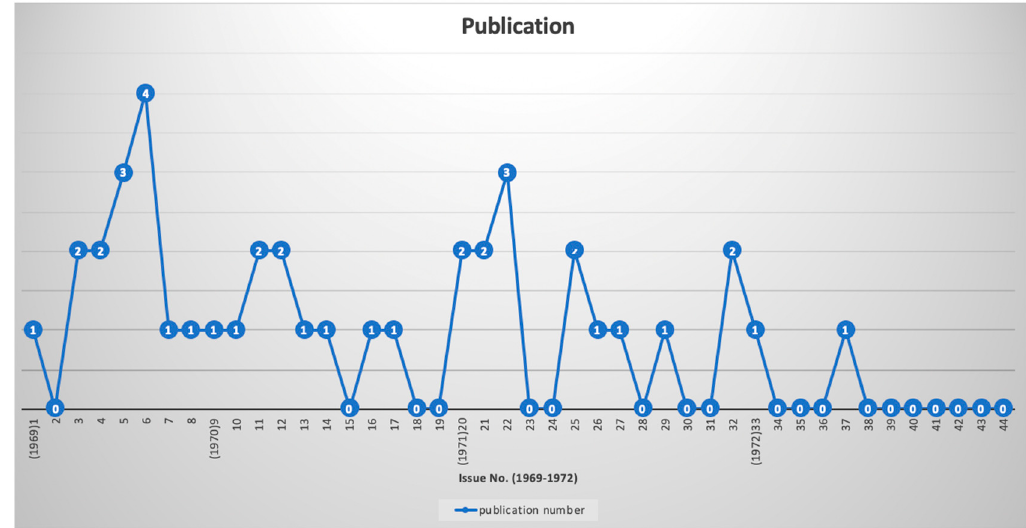
Figure 3. Publications by SGBI students in Nanyang Fojiao.